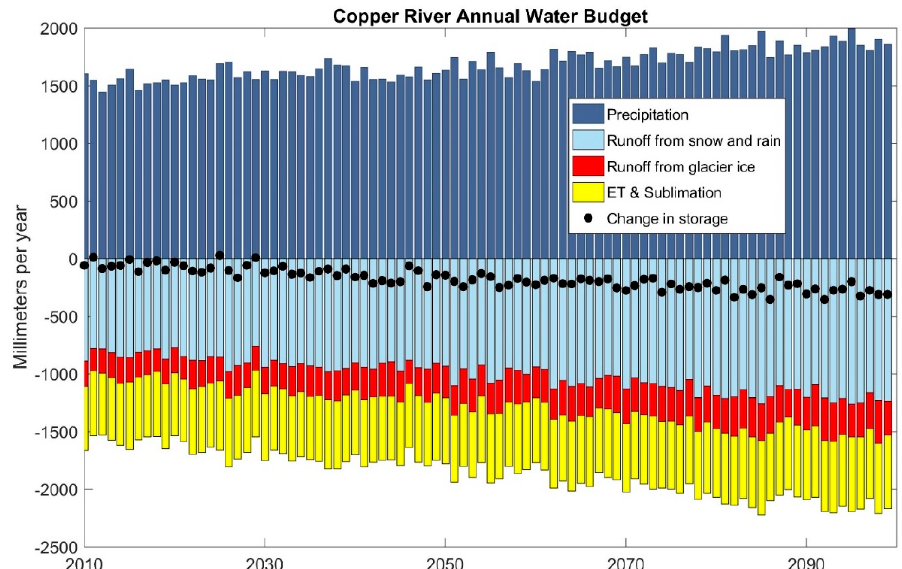
Figure 8. Future water budget from the RCP 8.5 five-model mean simulation. The following components of the water budget increase at a statistically significant rate ( p < 0.05): precipitation, runoff from rain and snow melt, runoff from glacier ice melt, and transfers to the atmosphere (ET and sublimation).